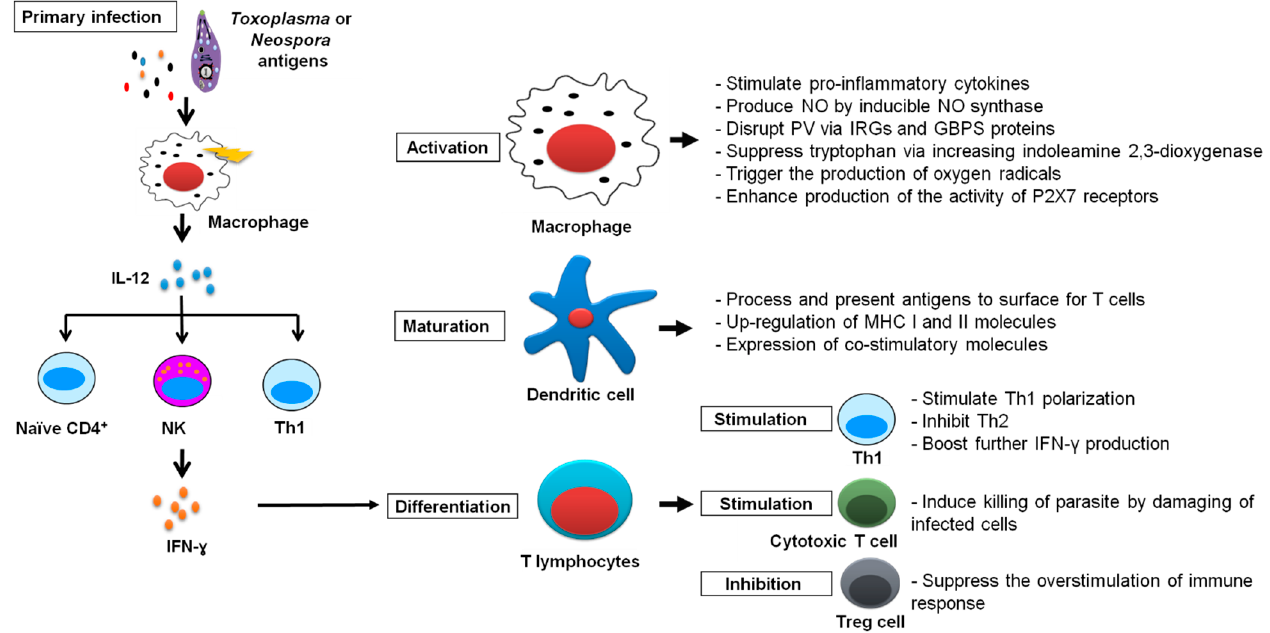
Figure 2. The role of IFN- γ in protection against T. gondii and N. caninum . Upon infection with T. gondii or N. caninum, macrophages as a first defense line secrete IL-12, which is a key factor to produce IFN- γ from T-helper and natural killer cells. IFN- γ interacts with IFN- γ -producing cells, such as macrophages, dendritic cells and T-cells. IFN- γ stimulates macrophages for combating intracellular pathogens through numerous pathways. Also, it enhances dendritic cells for MHC I and II up-regulation. For T-cells, IFN- γ interacts with T-cells to stimulate their differentiation toward the Th1 subset. Through positive feedback, IFN- γ enhances its own production in Th1 cells and inhibits Th2 and Th17 differentiation. IFN- γ is required for maturation of naïve T-cells to effector CD8+ T-cells. The IFN- γ is the main cytotoxic molecule released by these cells. Additionally, the immunosuppressive T regulatory cells are inhibited by IFN- γ .